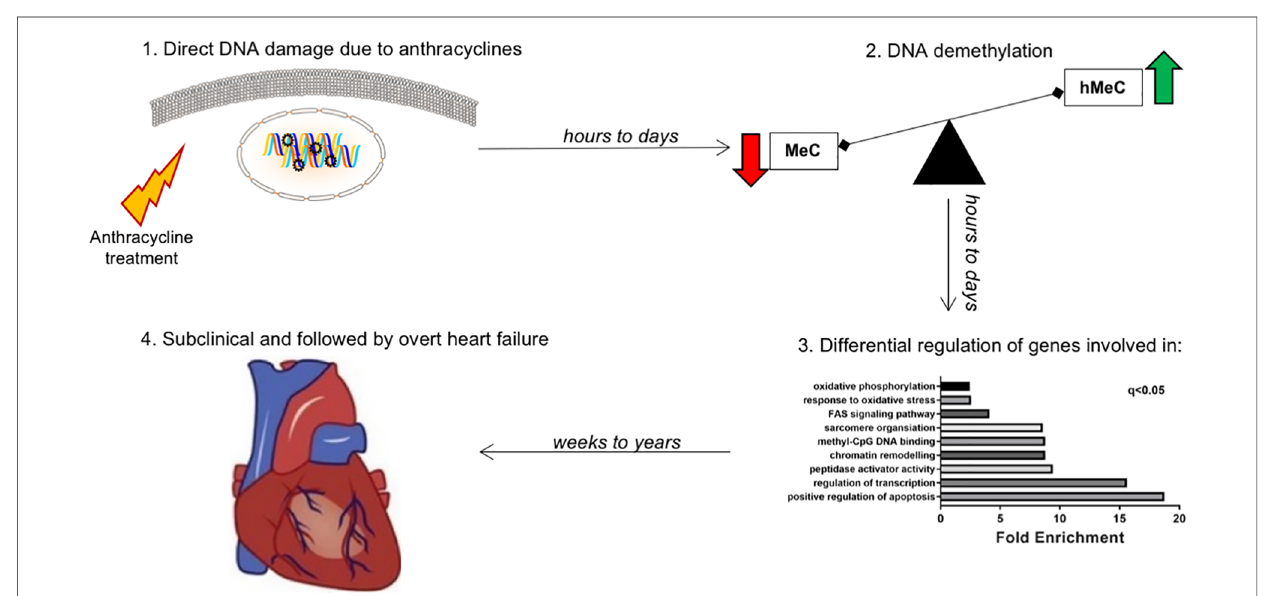
FIGURE 8 Working model: late-onset chemotherapy-associated heart failure is induced and maintained by a “ epigenetic memory ” from anthracycline administration. Hypothetical mechanism explaining the effect of cardiotoxicity even years after short-lived chemotherapy administration. The effect of anthracycline is an acute and long-lasting deregulation of genes involved in epigenetic modi fi cations, especially DNA methylation/demethylation. While methylation of genes ( via cytosine) leads to transcriptional repression, hydroxymethylation leads to transcriptional induction. This hMeC/MeC balance shift leads to increased senescence of cardiomyocytes, ultimately contributing to long term anthracycline cardiomyopathy.